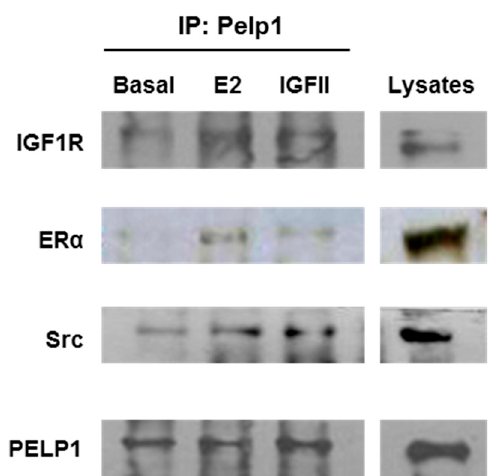
Figure 2. PELP1 is recruited to form a multiprotein complex in H295R cells after treatment with E2 and IGF-II. H295R cells were treated for 10 min with E2 (100 nM) or IGF-II (100 ng/mL). Total protein extract (500 μ g) was immunoprecipitated with 1 μ g of anti-PELP1 antibody. The samples were immunoblotted for IGF1R, ER α , and c-Src. Protein expression for each sample was normalized to PELP1 content. Results are representative of three independent experiments.